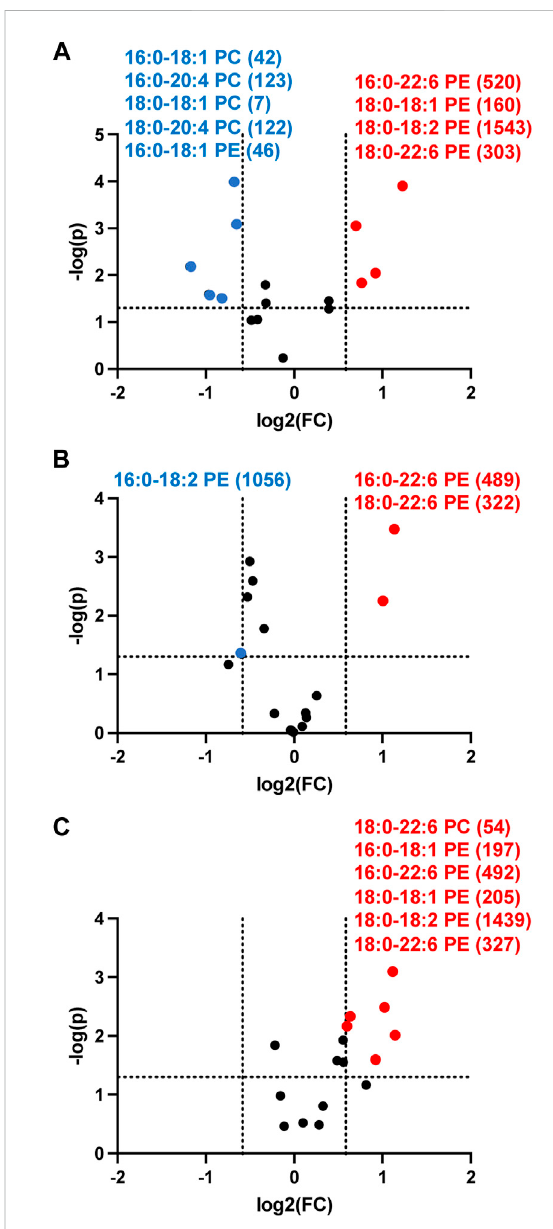
Volcano plot showing disparate changes in plasma phosphatidylethanolamine and phosphatidylcholine in septic rats. Ratswereinjectedwithcecalslurry( n =5)toelicitsepsisorvehicle ( n = 6) as described in “ Materials and Methods ” . Plasma was collected 4 h (A) , 8 h (B) , and 12 h (C) following cecal slurry treatment, and lipids were extracted and subjected to targeted analyses for PEandPC levels.Statisticalsigni fi cance wasevaluated by t -test ( p- value < 0.05) and fold change (FC) threshold at 1.5. (x following indicated molecular species) indicates mean value for cecal slurry treatment rat plasma levels in either nM or μ M for indicated PE or PC molecular species, respectively. Blue and red datapointsrepresentmolecularspeciesthatsigni fi cantlydecrease and increase, respectively and meet the FC criteria of 1.5.